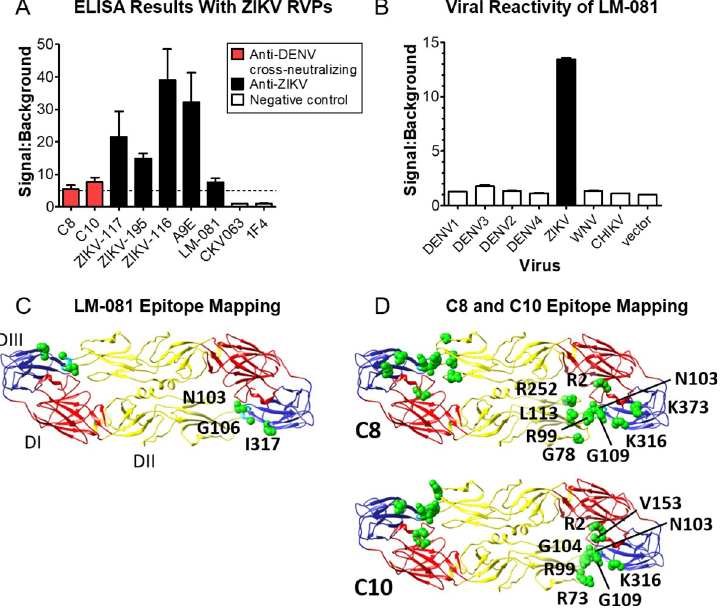
Fig 2. ZIKV RVPs are antigenically equivalent to live virus. (A) ELISA was performed using ZIKV RVPs with various conformational MAbs. Detection MAbs were two anti-DENV MAbs with ZIKV cross-neutralizing activity (C8, C10), five neutralizing anti-ZIKV MAbs (ZIKV-117, ZIKV195, ZIKV116, A9E, LM-081), and two negative control MAbs (CHIKV-specific CKV063 and DENV1-specific 1F4). The capture MAb was a mouse anti-fusion loop MAb (4G2). Mean signal to background ratio (S:B) of three concentrations of detection MAb (1, 2, and 4 μ g/mL) is shown with the SD (error bars). Dashed horizontal line represents S:B = 5. ( B) Flow cytometry analysis of LM-081 binding to viral envelope proteins expressed in human cells shows that LM-081 binds specifically to ZIKV and not to other flaviviruses, including DENV serotypes 1–4. (C) Shotgun mutagenesis epitope mapping of LM-081 revealed two critical residues in the fusion loop on one E monomer (N103, G106), and one critical residue on Domain III of an adjacent monomer (I317). (D) Shotgun mutagenesis epitope mapping of anti-DENV EDE MAbs C8 and C10 reveal critical residues (green spheres), shown on the ZIKV E ectodomain (PDB # 5IRE; [11]).